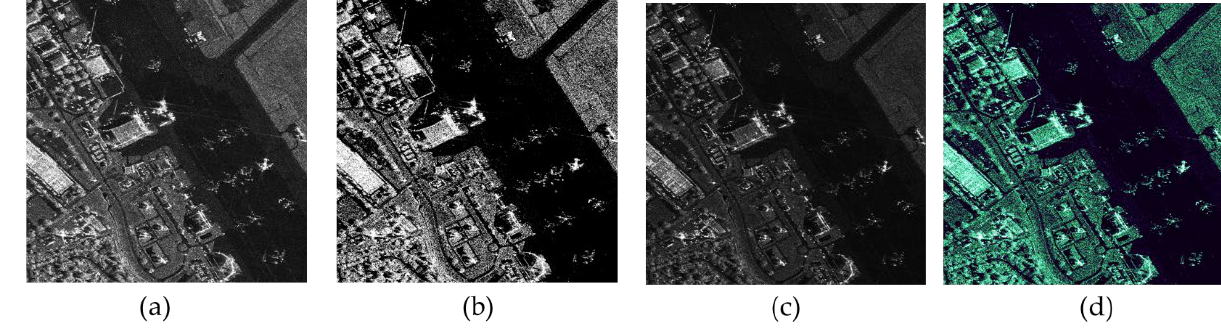
Figure 5. Data visualization based on KNT in a different channel. ( a ) R-channel ( b ) G-channel ( c ) B-channel ( d ) RGB-channel.